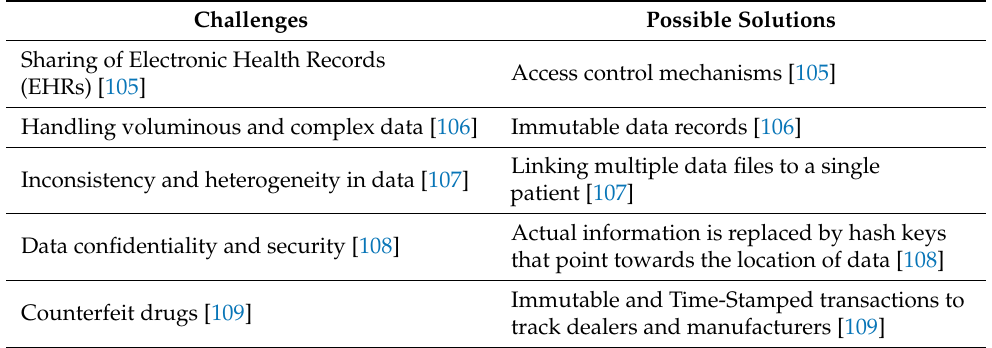
Table 2. Blockchain for